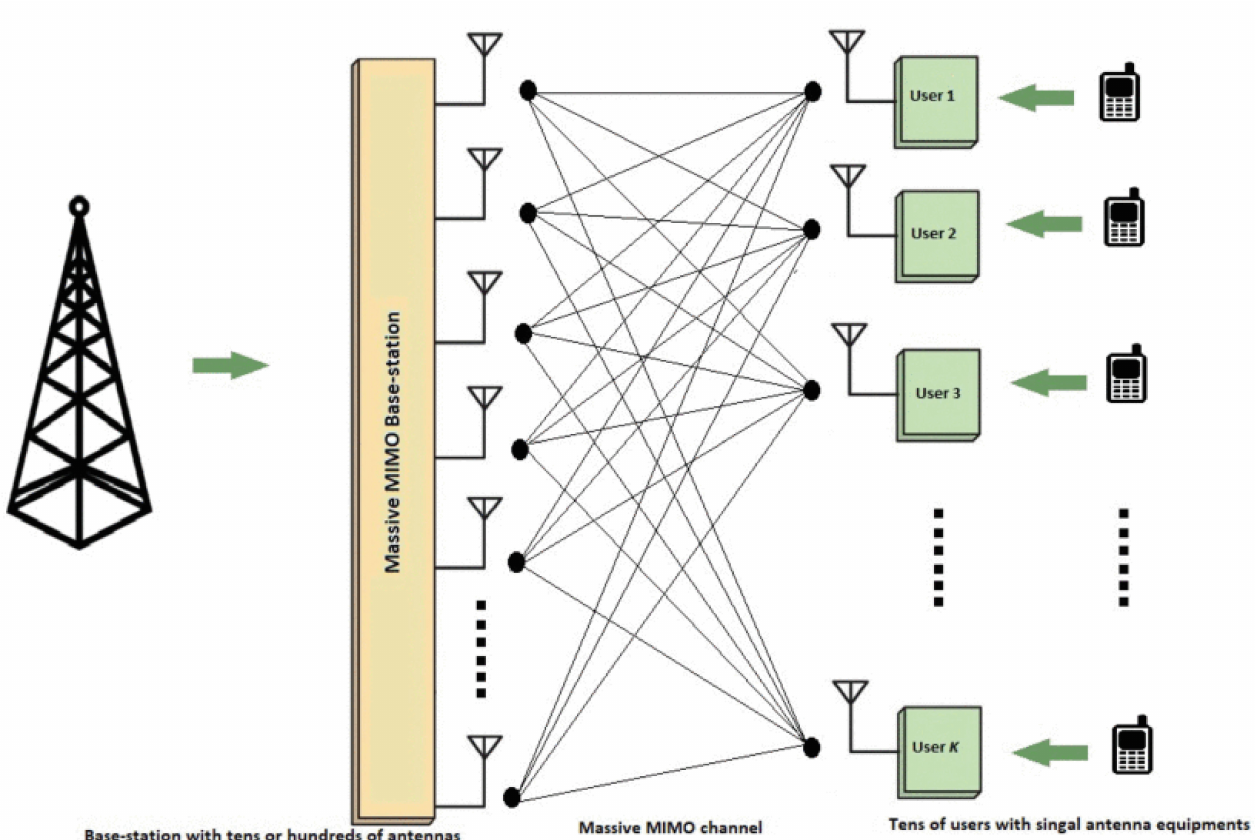
Figure 7. Massive MIMO architecture